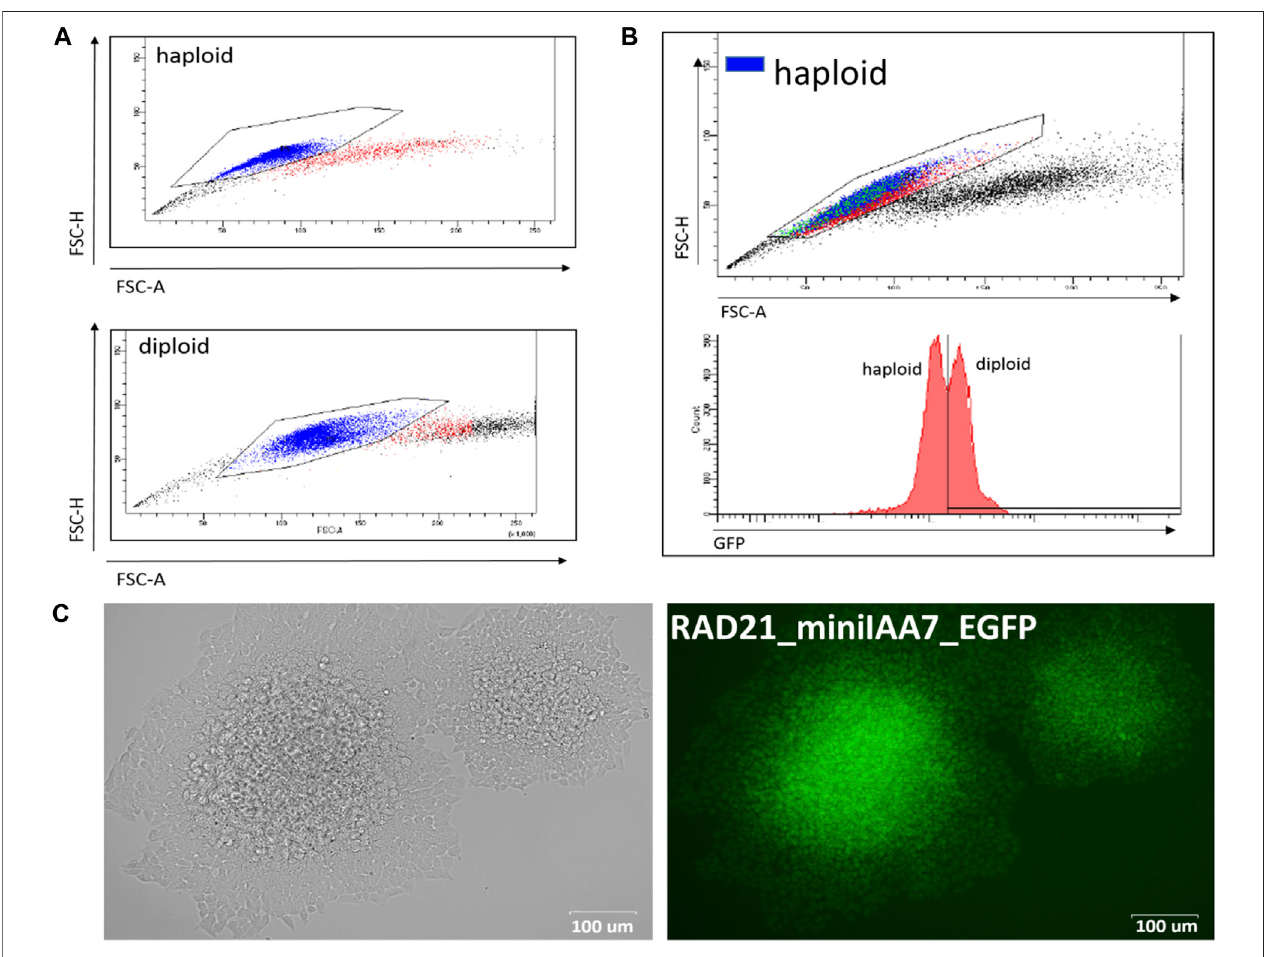
FIGURE 2 | Haploid and diploid HAP1 clones could be reliably separated by cell size using FACS or visual clues. (A) FACS plots for haploid and diploid HAP1 clones. (B) MosaicHAP1cloneconsistingoftwosubpopulationsinequalproportions.Blue/redhighlightindicateshaploid/diploidsubpopulations,respectively. (C) Two eGFP-positive RAD21-miniIAA7-eGFP clones that show signi fi cant cell size differences, making it easy to pick the correct clone (haploid clone is on the